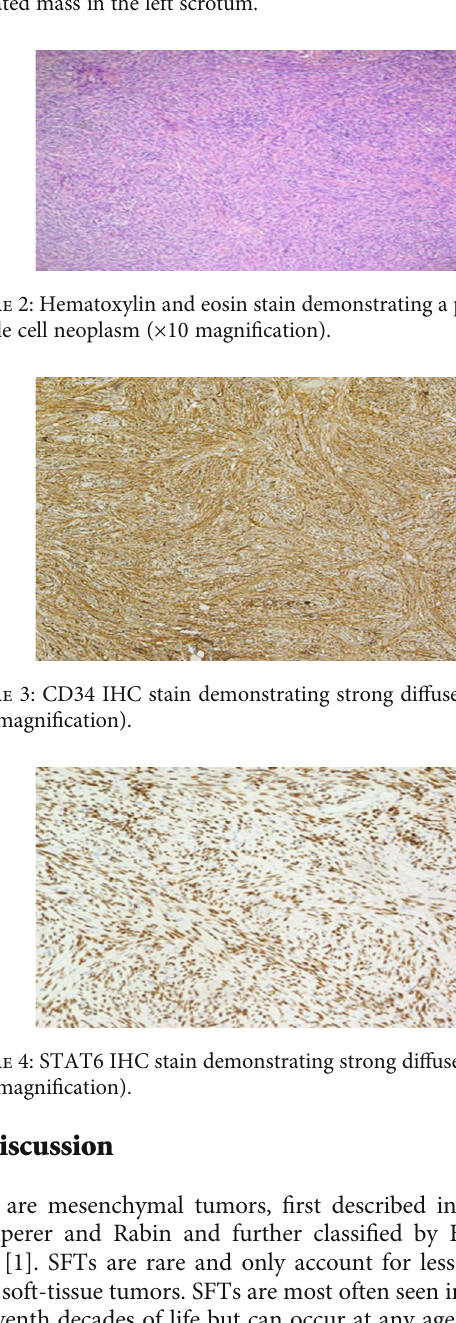
Figure 1: CT scan of the abdomen and pelvis revealed a large lobulated mass in the left scrotum.